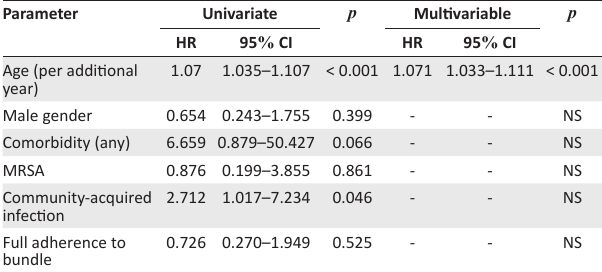
TABLE 4: Cox regression analysis to predict the 90-day mortality in patients with Staphylococcus aureus bacteraemia. Parameter